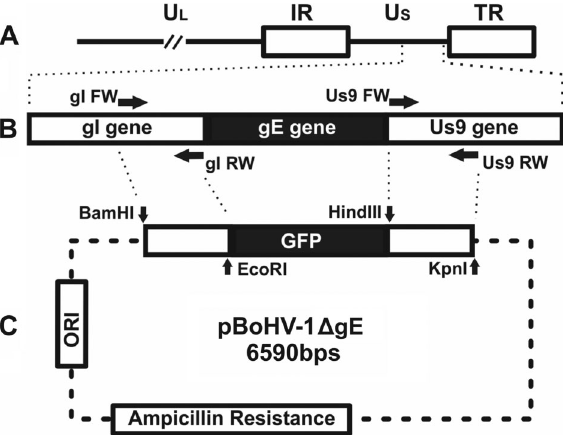
Figure 1. Strategy for the construction of the gE deletion plasmid. A , Schematic organization of the BoHV-1 genome and their unique long (U L ) and short (U S ) regions and repeats (internal, IR, and terminal, TR). B , Ampli fi ed view of the organization of the BoHV-1 genome within the U S region corresponding to the gE gene. Arrows show the primers used for amplifying the gE fl anking regions. C , Schematic organization of the deletion plasmid containing the regions for homologous recombination and the restriction endonuclease sites used in the cloning